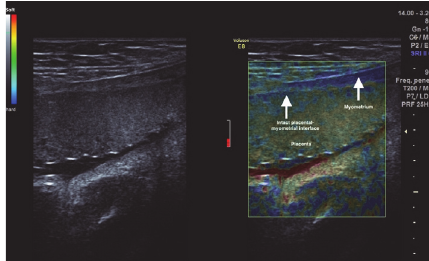
Figure 3: MRI demonstrating placental invasion into the myo- metrium (arrow).